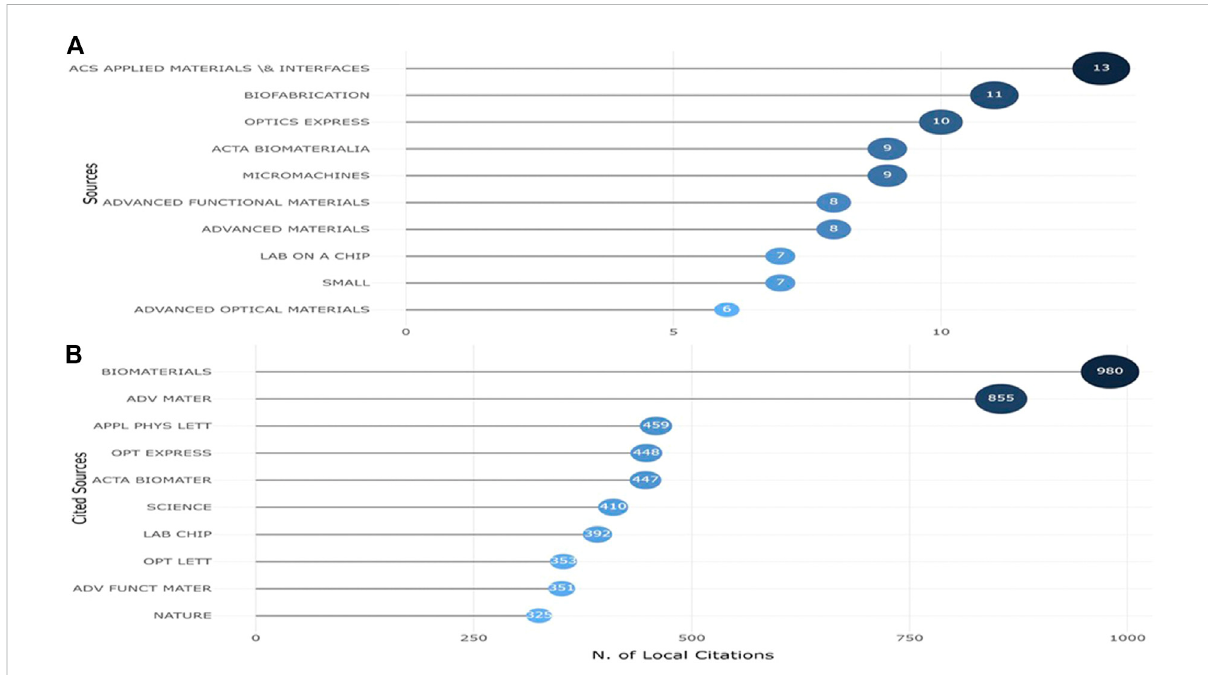
FIGURE 6 The dual-map overlay of journals related to applications of TPP in biomedical fi eld.